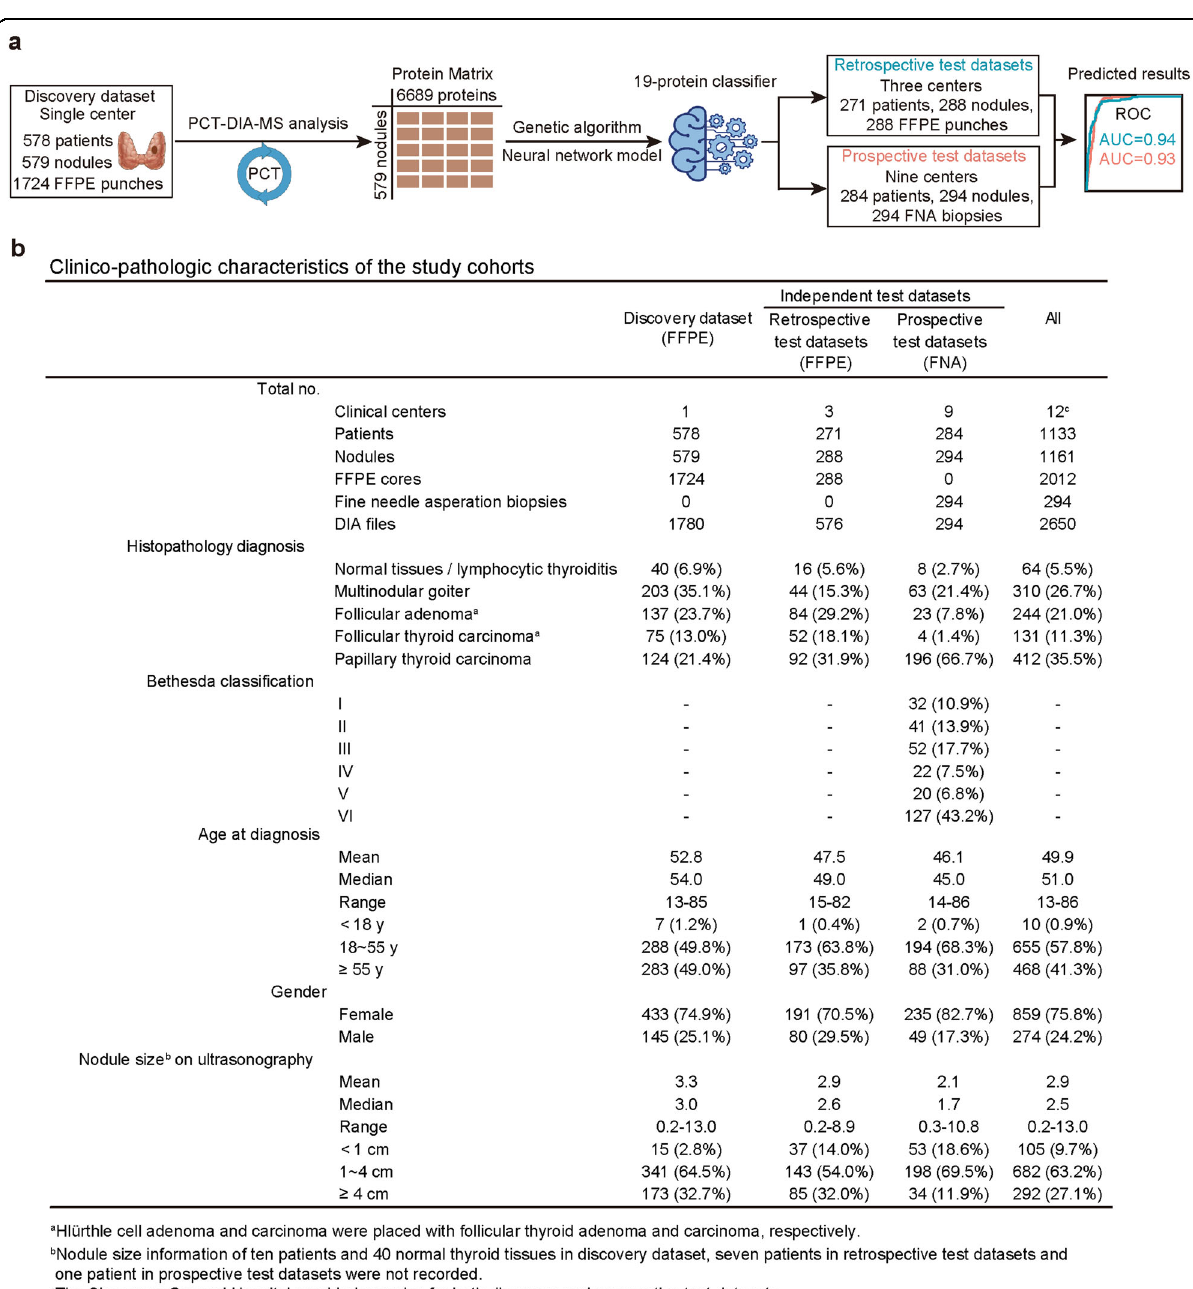
Fig. 1 Schematic view of the study and clinic-pathologic characteristics. a The project design and work fl ow of the FFPE-PCT-DIA pipeline. b Clinic-pathologic characteristics of the study